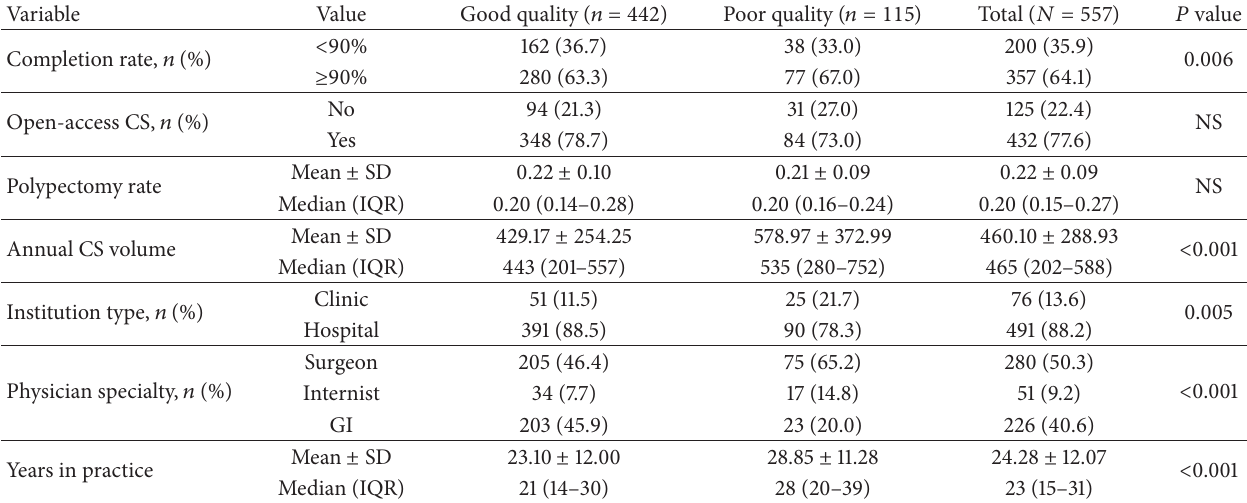
Table 2: Physician and institution factors associated with good quality CS reporting.